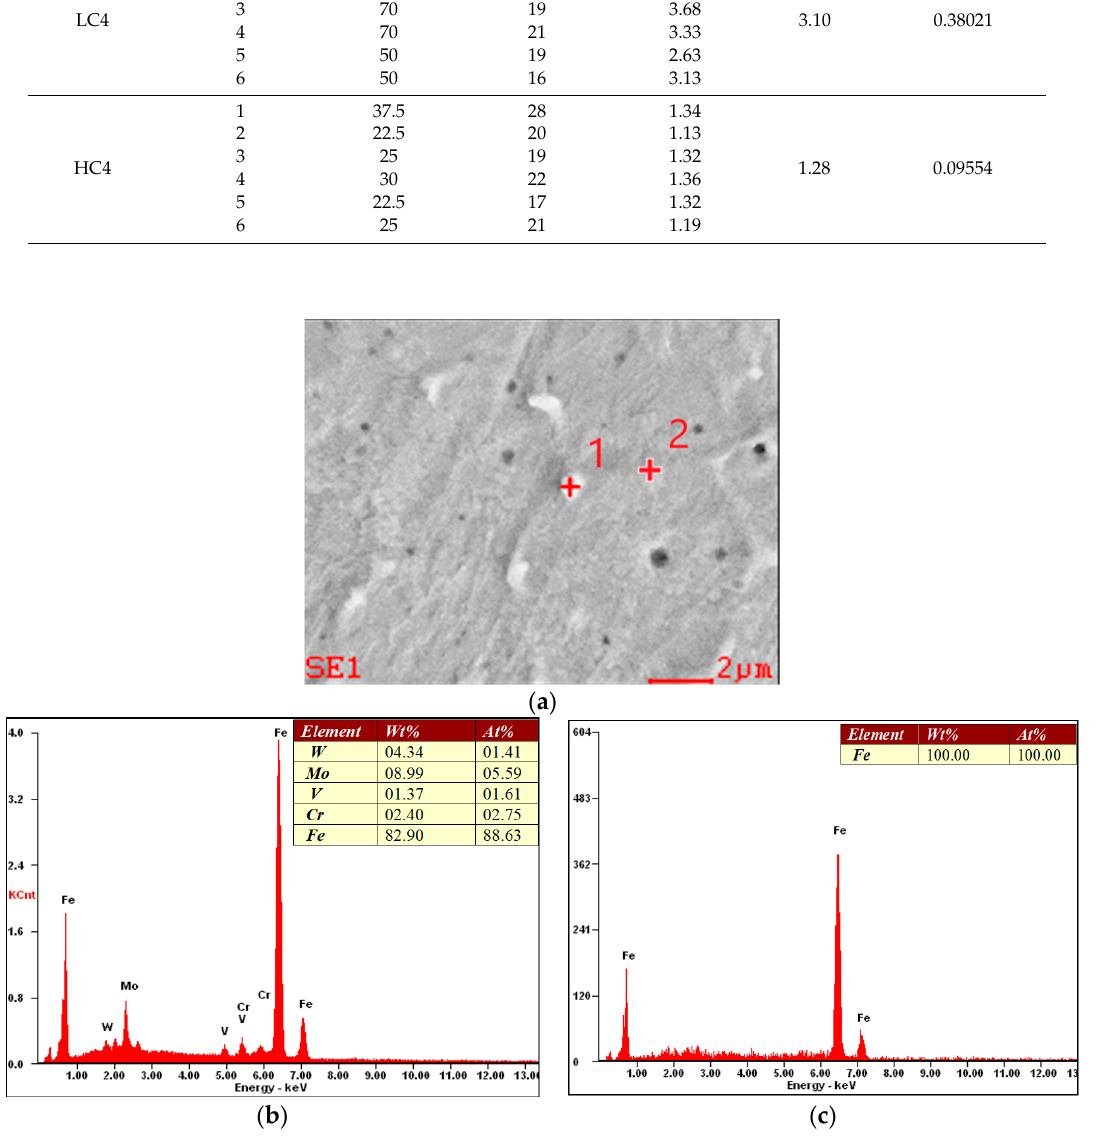
Figure 16. SEM micrograph ( a ) of the middle region of the clad of stringer bead HC4 (Table 3) chosen for energy-dispersive spectrometer (EDS) analysis: ( b ) EDS spectrum of the precipitation (a white dot in point No. 1); ( c ) EDS spectrum of the dendrite area (a gray region below point No.